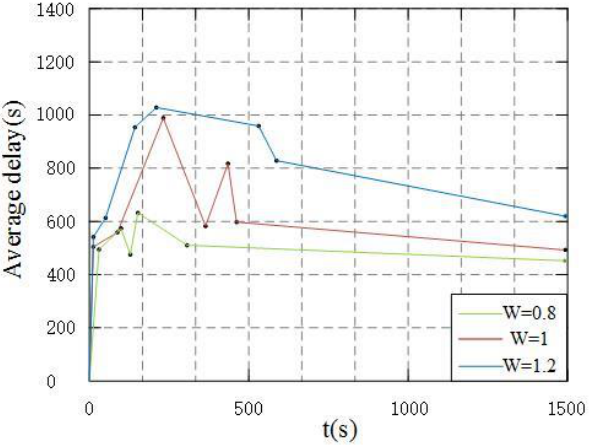
Figure 5. Curve of low-priority queue length changing with weight.